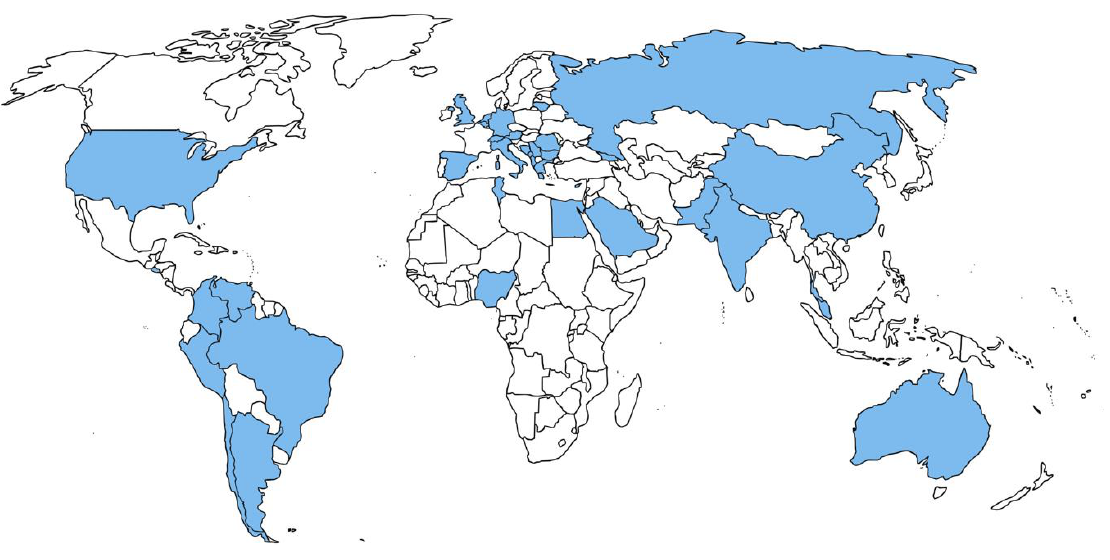
Figure 2. Participating countries.